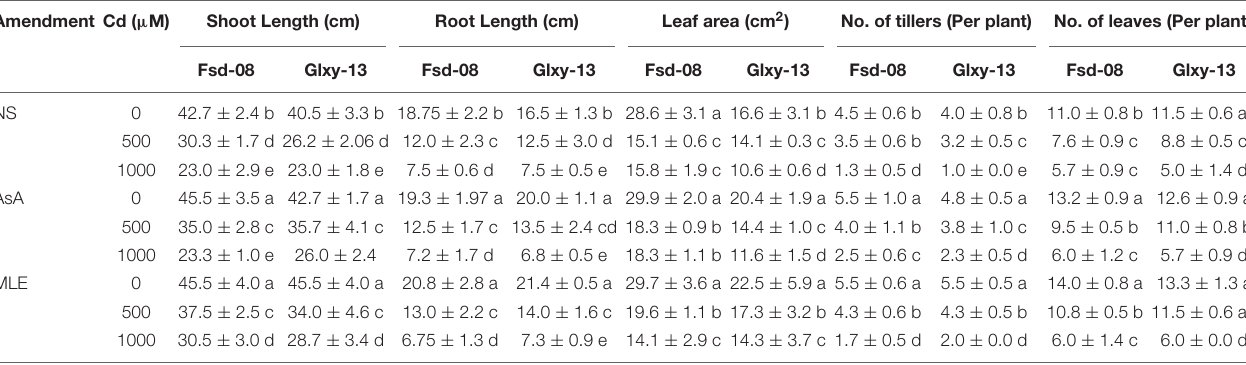
TABLE 1 | Variation among morphological attributes under the foliar spray of ascorbic acid (AsA) and moringa leaf extract (MLE), along with no-spray (NS) in two wheat cultivars (Fsd-08 and Glxy-13) exposed to the cadmium (Cd) toxicity. Amendment Cd ( µ M)